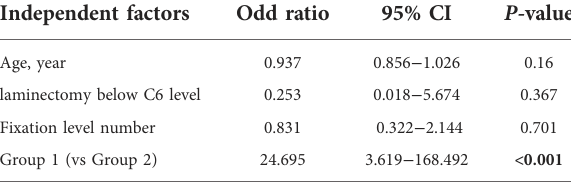
Table 4 Multivariable analysis of better posterior cervical lordosis. Table 5 Postoperative complications of 55 patients with CM due to long-segment massive OPLL undergoing cervical operation.